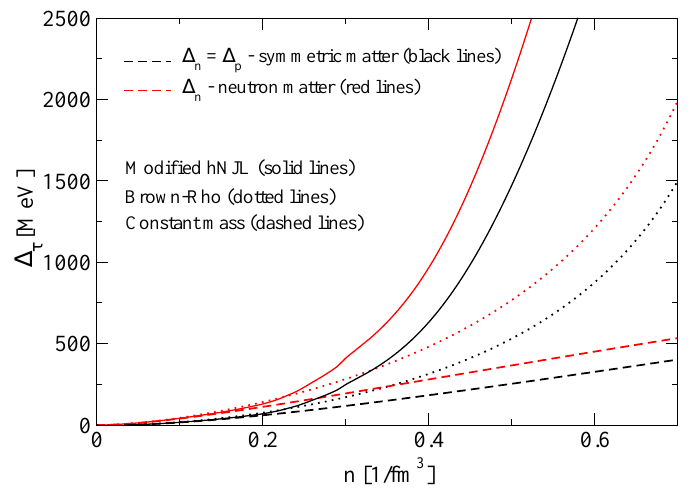
Figure 3. The quark exchange contributions to self-energy for symmetric nuclear matter (black lines) and for pure neutron matter (red lines) as a function of the baryon density. Constant quark mass case (dashed lines), Brown–Rho scaling (dotted lines) and hNJL model case (solid